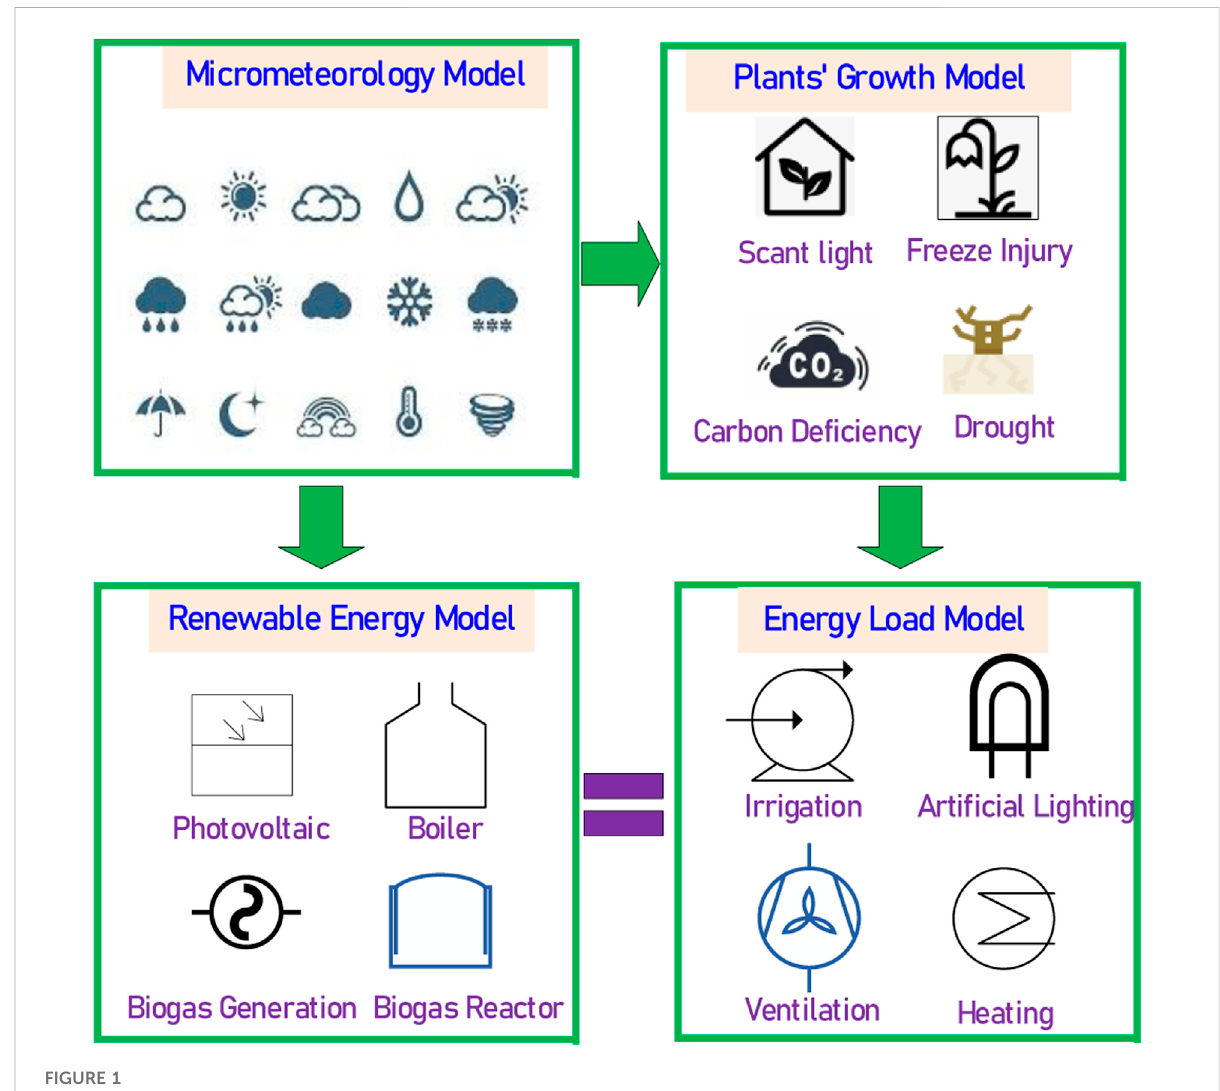
FIGURE 1 The model architecture of an AEI for the planting